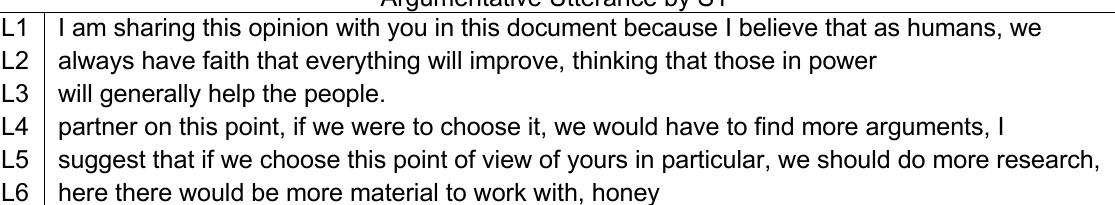
Argumentative Utterance by